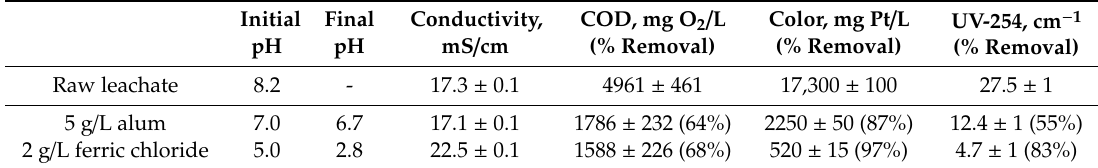
Table 3. Removal of contaminants at optimal conditions with alum and ferric chloride, which are the initial conditions for the subsequent Fenton